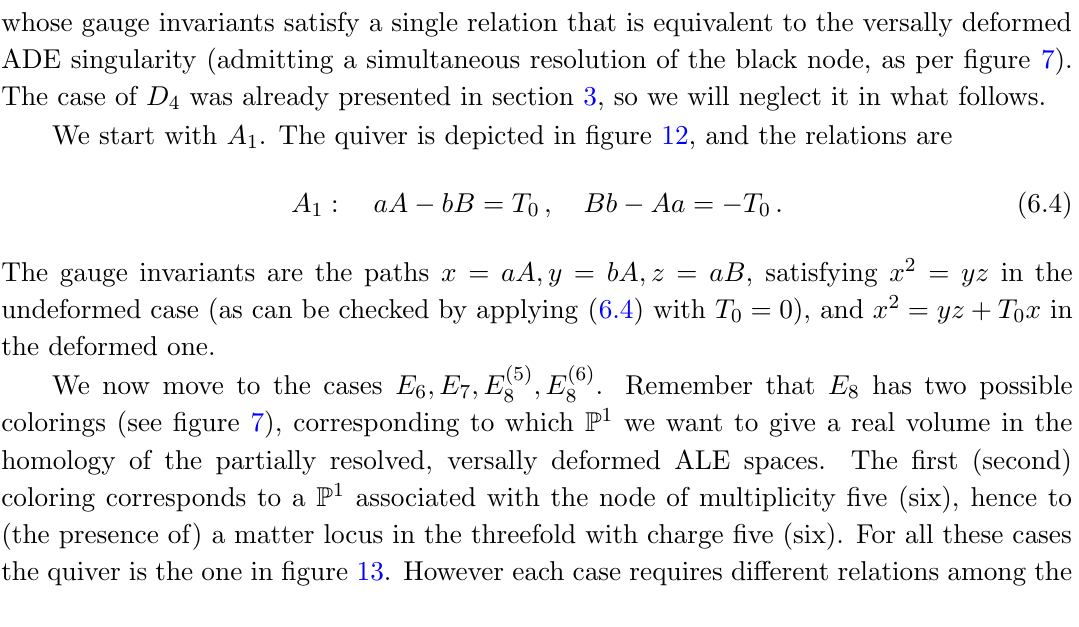
Figure 12 . The quiver with relations reproducing the threefold family of deformed A singularities admitting a simultaneous